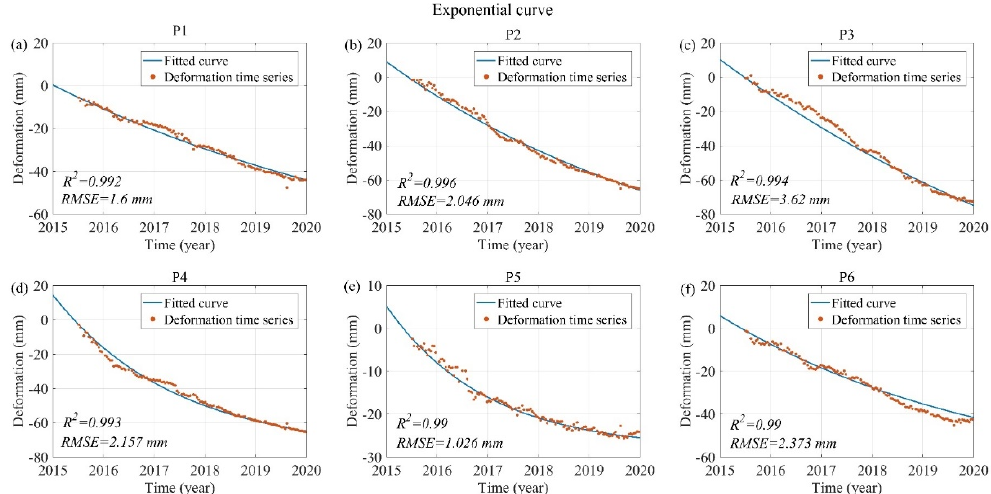
Figure 7. Exponential curve fitting of ( a ) P1, ( b ) P2, ( c ) P3, ( d ) P4, ( e ) P5 and ( f ) P6. Locations of points P1−P6 are shown in Figure A1.